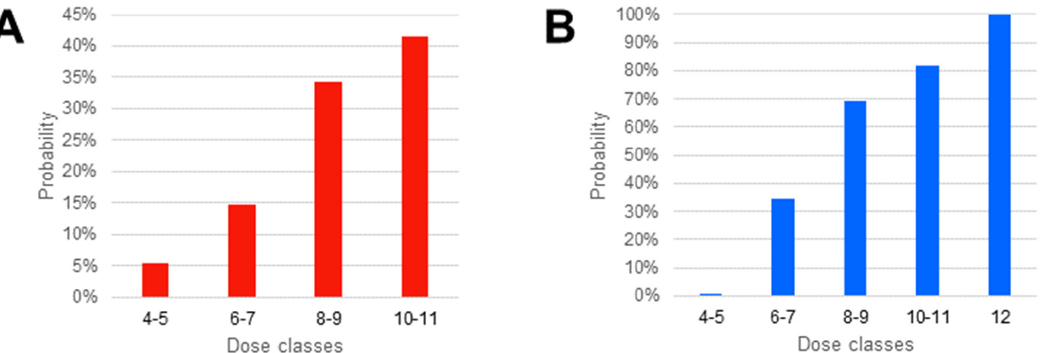
Figure 5. Analysis of predicted concentrations in 10,000 patients simulated through Monte-Carlo method: ( A ) probability of attaining a C min > 24.3 mg/L, as tolerability index; ( B ) probability of at- taining a C max > 60 mg/L, as preliminary efficacy index.